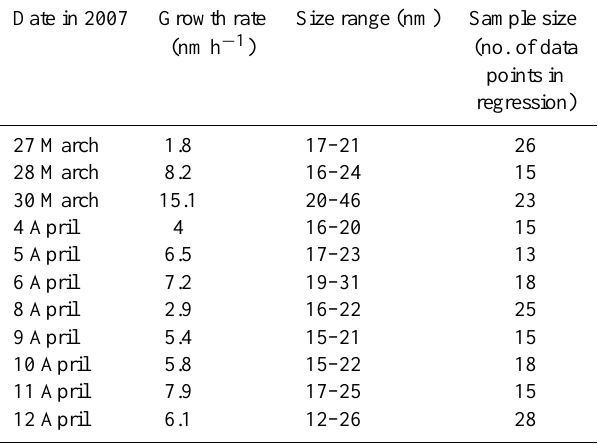
Table 2. Nucleation mode negative (–) and positive (+) ion growth rates (GRs) calculated from the AIS data. Blank spaces indicate values that could not be reliably